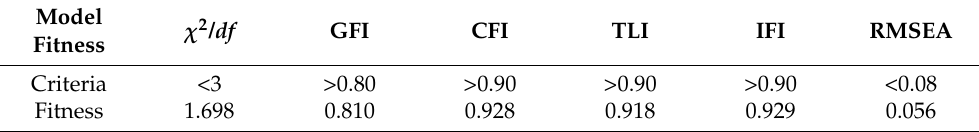
Table 5. Goodness of fit of